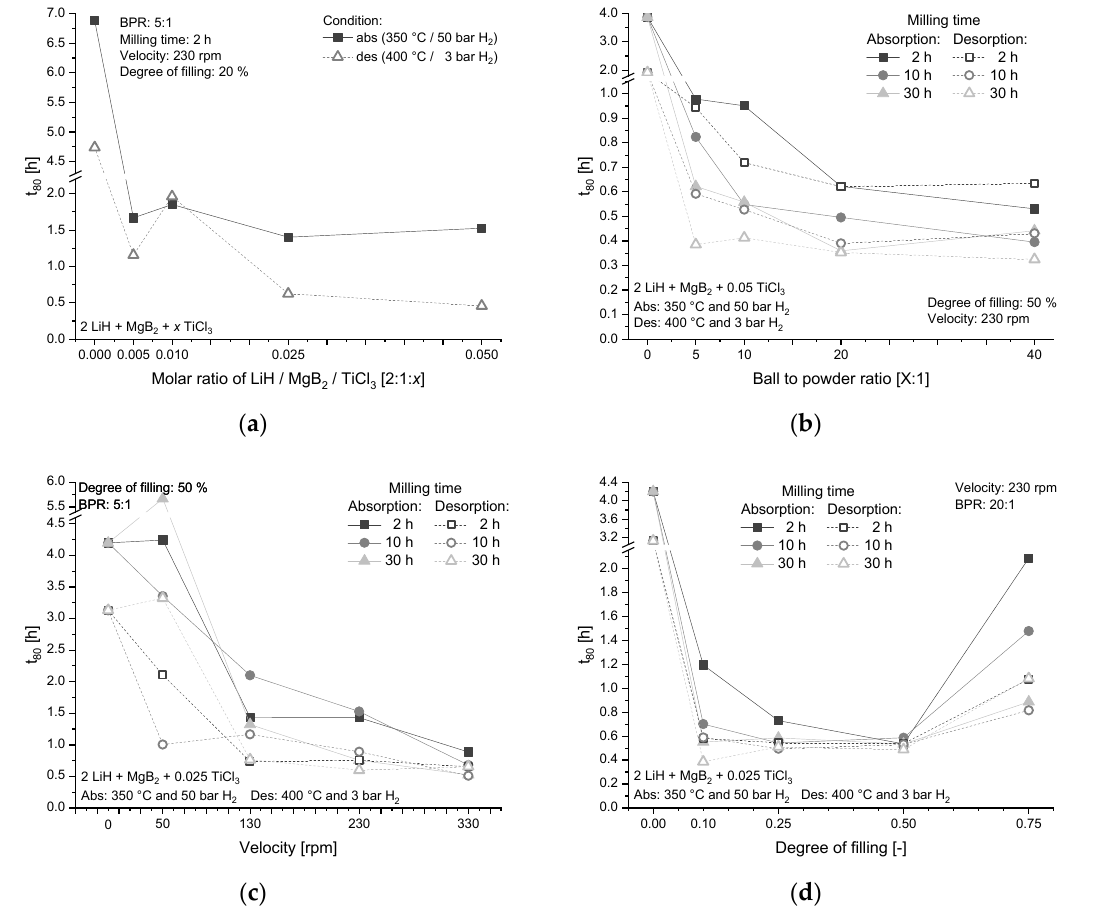
Figure 2. Kinetic behavior, expressed by means of t 80 , as function of ( a ) additive content, ( b ) BPR, ( c ) milling velocity, and ( d ) degree of filling. All sets are for absorption and desorption, and display different milling times.